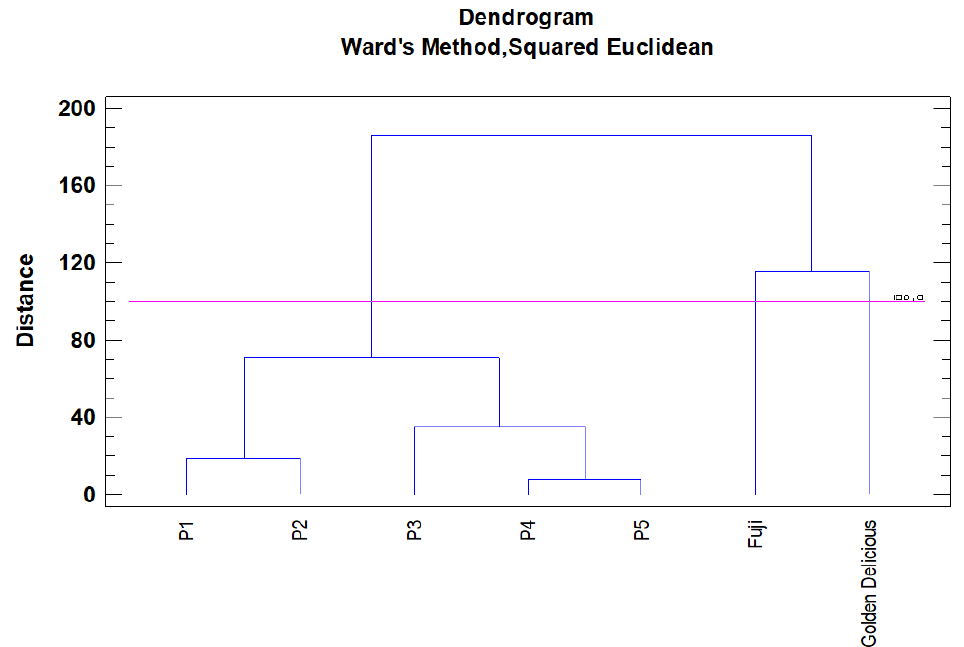
Figure 4. Dendrogram constructed with the number of physicochemical traits evaluated following Ward’s method. Squared Euclidean distance represents dissimilarity.